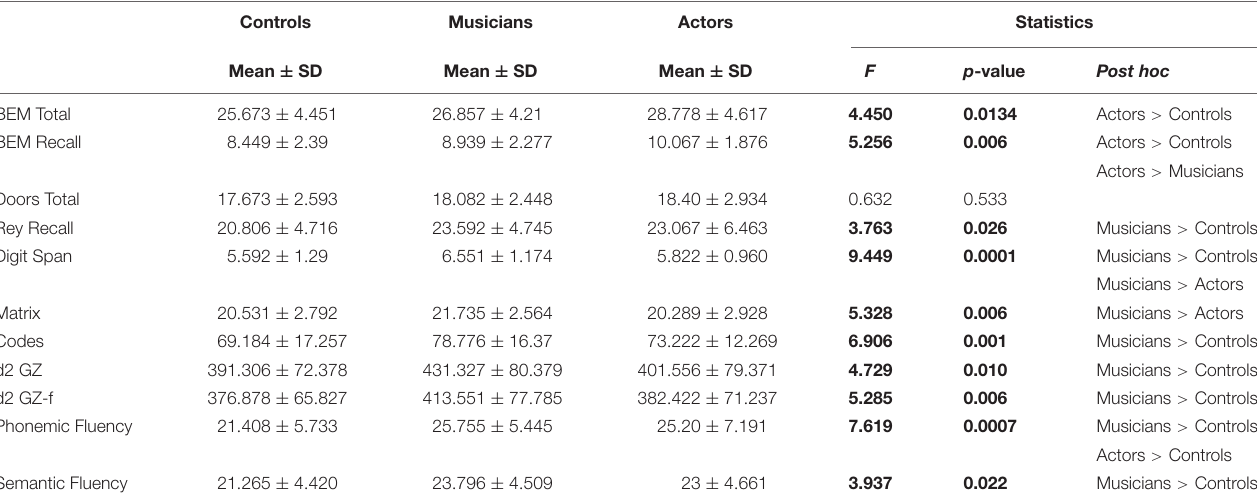
TABLE 4 | Statistical results of MANCOVA for each cognitive